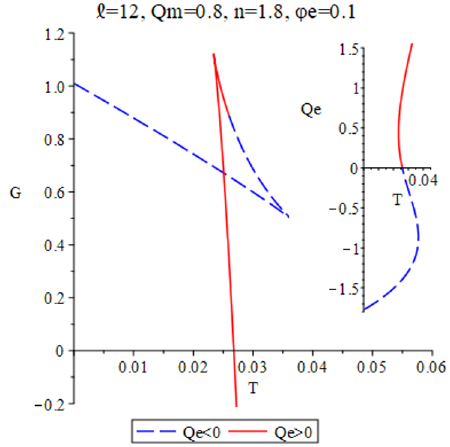
Figure 9 . Charge-Changing Phase Transition. Plotting free energy as a function of temperature for Q m = 0 . 8 , n = 1 . 8 , φ e = 0 . 1 , and ‘ = 12 , we observe a first order large/small phase transition, where the electric charge changes sign. The inset shows the behaviour of the charge as a function of temperature. This behaviour is typical of case Ic, and for its magnetic counterpart, case